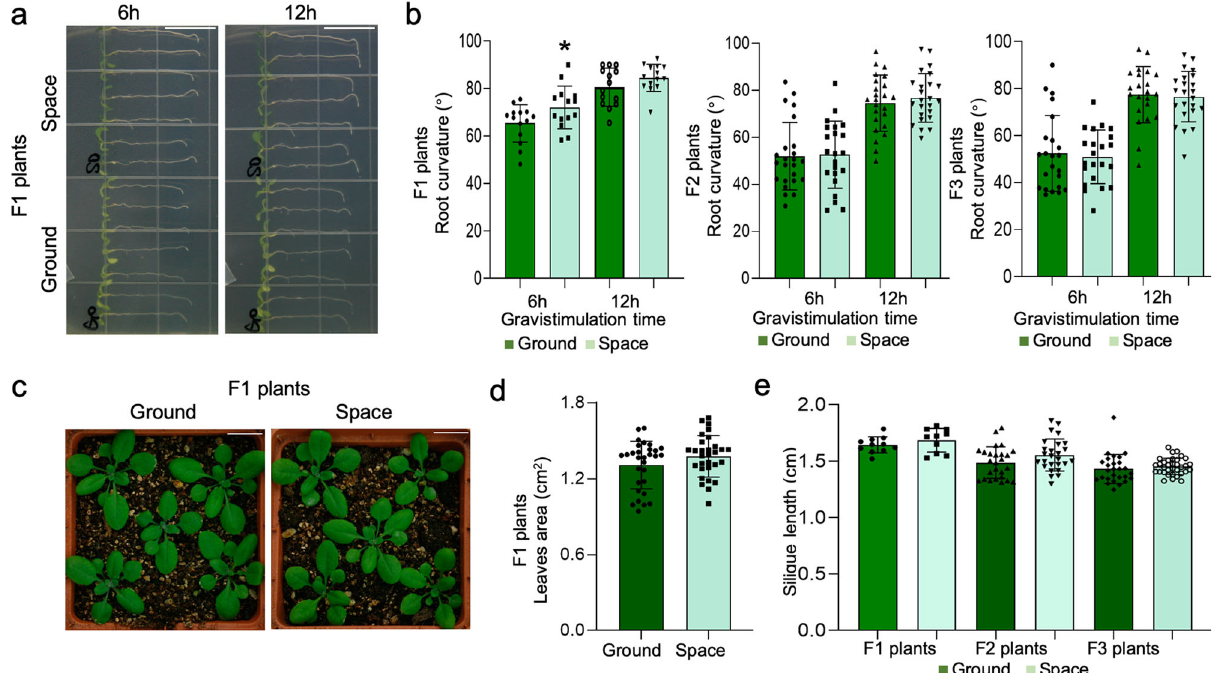
Fig. 3 Comparison of the gravitropic orientation analysis, leaf area, and silique length phenotypes in the offspring of space fl ight and the ground control plants. a , b The 90 o change in gravitropic orientation analysis of the offspring seedlings of the space fl ight and ground control samples. The experiment was conducted in the F1 generation and the F2/F3 generations of Arabidopsis seedlings at 8-d-old and 7-d-old, respectively. The data shown are the average values of 14 samples in the F1 generation ( n = 14) and 24 samples in the F2/F3 generation ( n = 24). c , d The rosette leaf area of the offspring of space fl ight and ground control samples. Leaf area was determined by using ImageJ software. The data shown are the mean ± standard deviation values obtained for eight leaves ( n > 30). e The silique length analysis in the offspring of space fl ight and ground samples. The data shown are the mean ± standard deviation values ( n > 10). An asterisk * indicates a statistically signi fi cant difference between the samples by using Student ’ s two-tailed t- test ( p < 0.05). Scale bar indicates 1